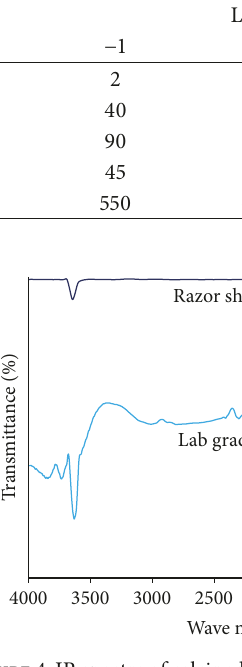
Figure 4: IR spectra of calcined lab grade CaO and Razor shell CaO.